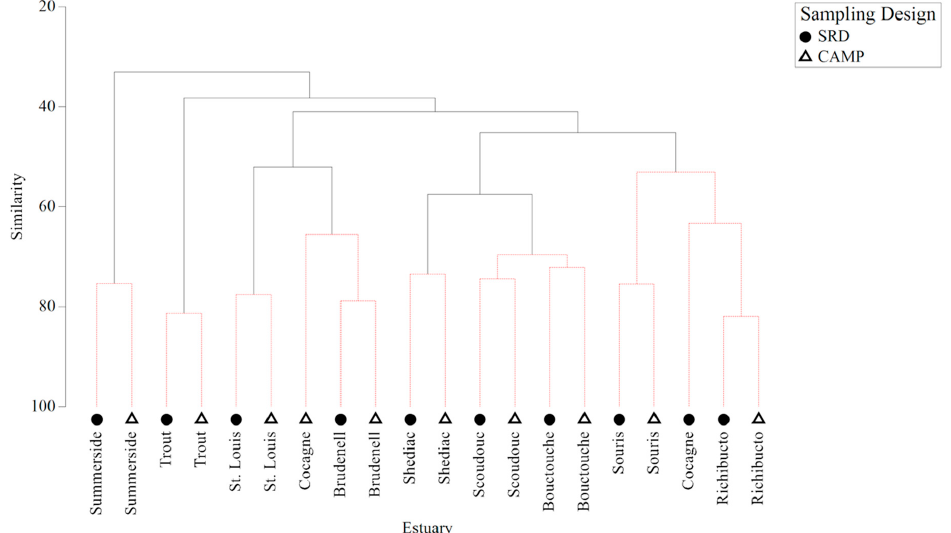
Figure 2. Cluster analysis on Bray–Curtis similarities for nekton abundance data (square-root transformed) for each sampling design (Community Aquatic Monitoring Program [CAMP] vs. Stratified Random Design [SRD]—average of station data) for each estuary. Dotted lines represent similarity profile (SIMPROF) results where groups of samples are not significantly different (5% significance).